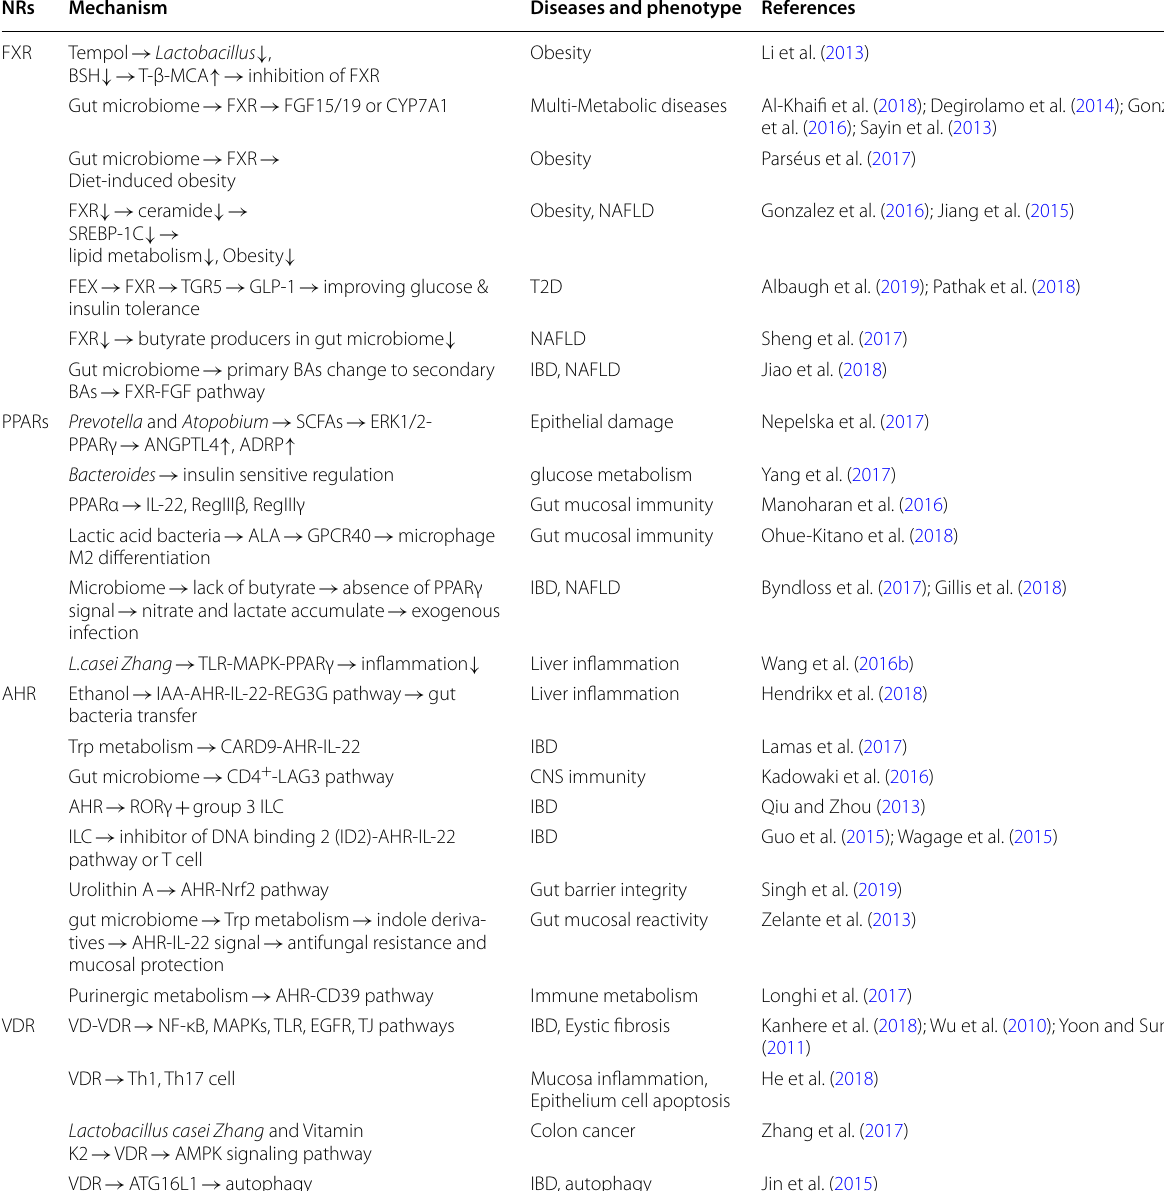
Table 1 NRs in the crosstalk of gut microbiome‑host